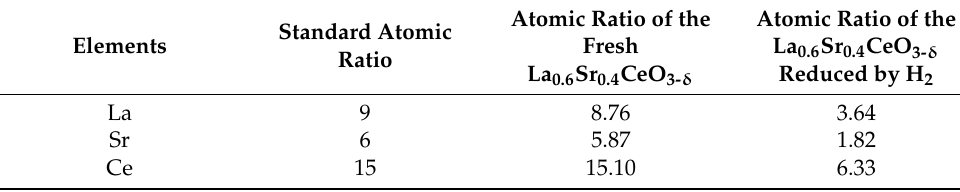
Figure 3. SEM-EDS mapping images of the fresh La 0 . 6 Sr 0 . 4 CeO 3- δ : ( a ) the selected area of SEM-EDS mapping; ( b ) lanthanum; ( c ) strontium; ( d ) cerium; ( e ) oxygen. Table 1. The SEM-EDS data of the La 0.6 Sr 0.4 CeO 3- δ sample. Table 1. The SEM-EDS data of the La 0 . 6 Sr 0 . 4 CeO 3- δ sample.